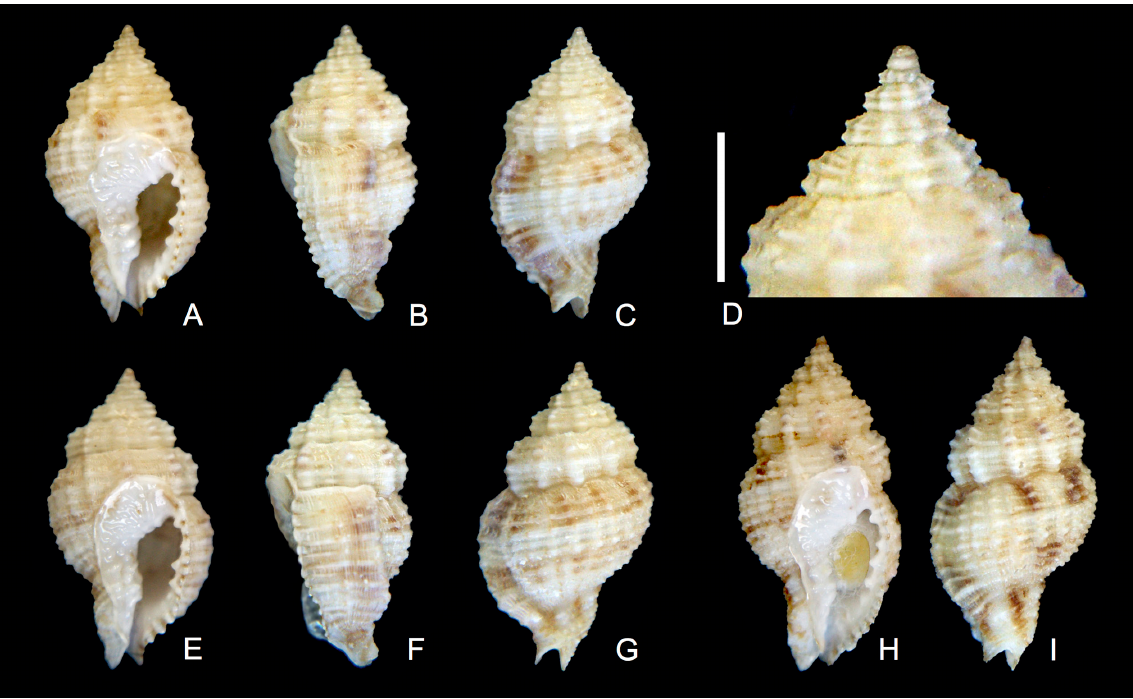
Fig. 4. Sinetectula farinosa (Gould, 1850) gen. et comb. nov. A–D . Specimen from the Marshall Islands, Kwajalein Atoll, in cave at Oceanside of West reef, depth 12 m, 14.6 mm long (KF 4766). E–G . Specimen with same collection data as for preceding, 15.6 mm long (KF 4766). H–I . Specimen from Mozambique, Fernao Velosa Bay, depth 3–4 m, 18.6 mm long (KF 5378). Scale bar: 2.0